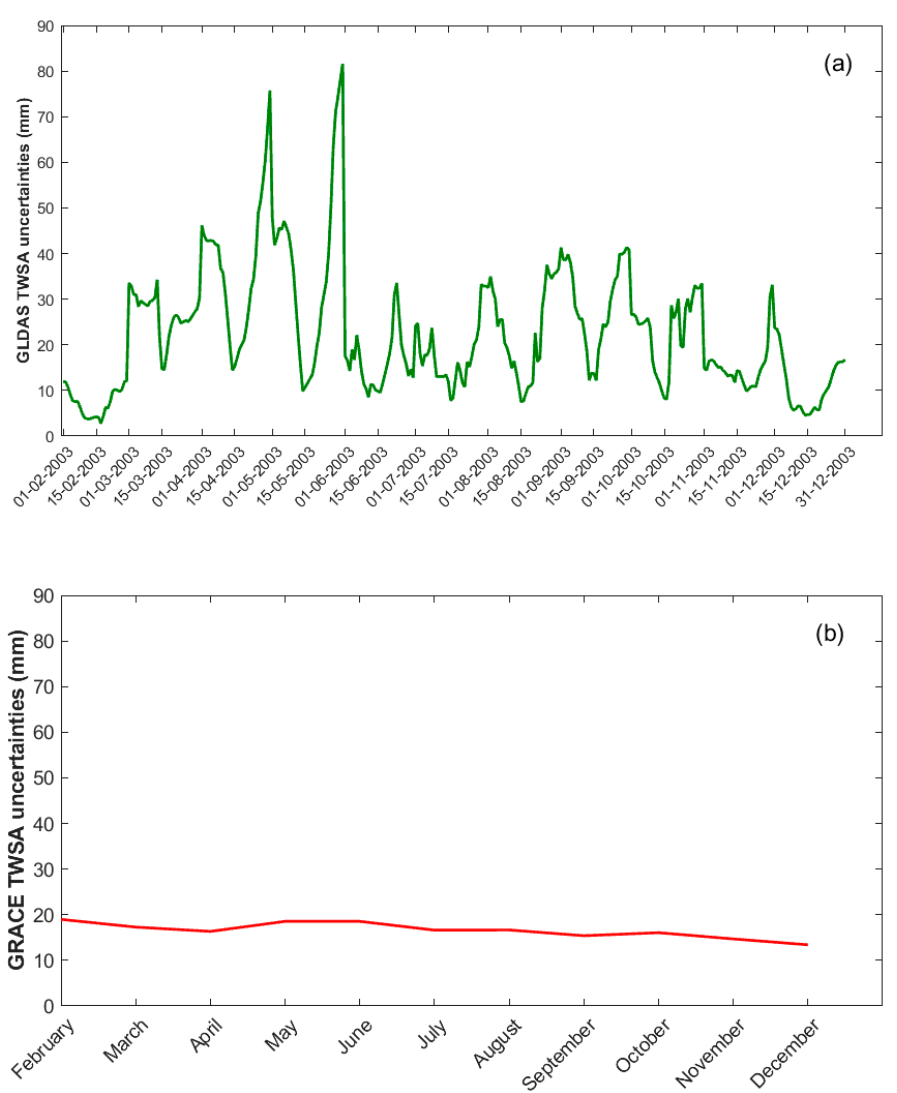
Figure 5. ( a ) Daily time series of maximum GLDAS TWSA uncertainties over the study region, ( b ) Monthly time series of GRACE TWSA uncertainties over the study region, between February and December 2003